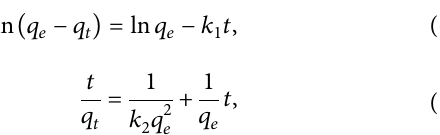
Table 1: The adsorption isothermal parameters of RhB onto CAC/CoFe Langmuir